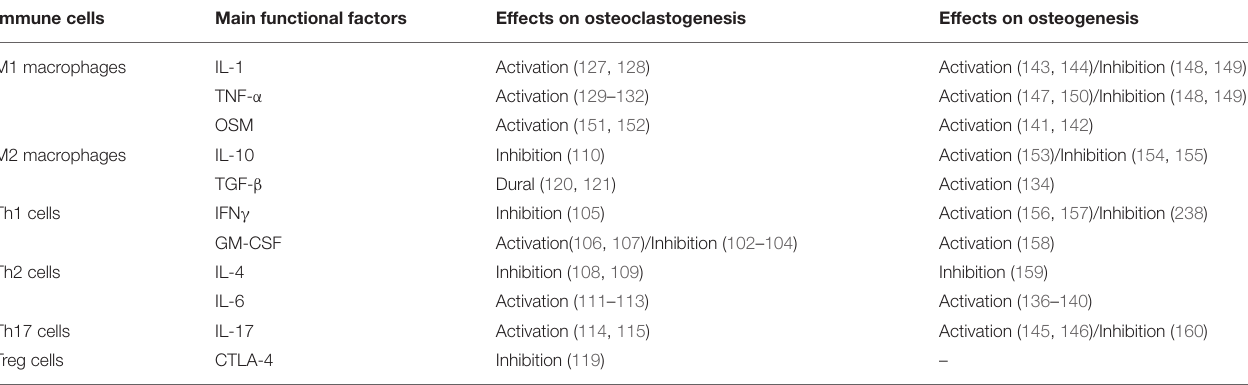
TABLE 1 | Effects of immune cells on bone remodeling. Immune